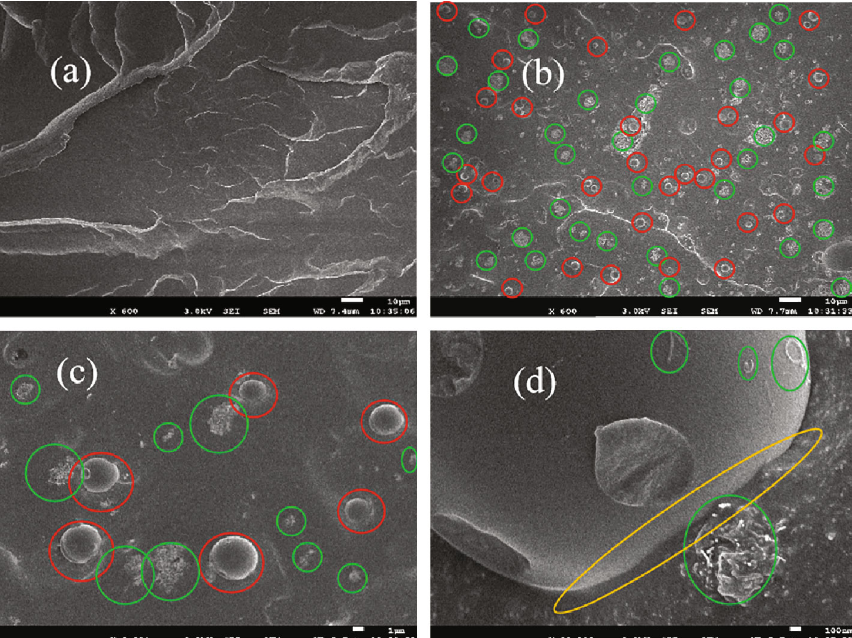
Figure 5: (a) SEM images of silicon rubber. (b, c) SEM images of silicon rubber-based nanocomposites with CNTs-PSQ. (d) SEM images of interface between CNTs, PSQ, and SR matrix.